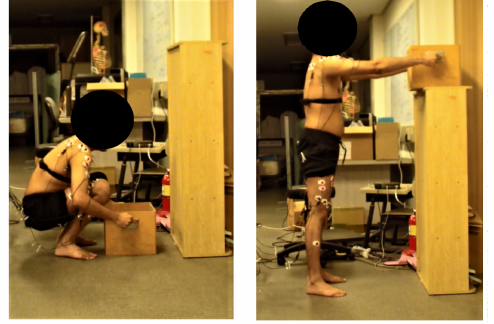
Figure 2. Symmetric lifting and